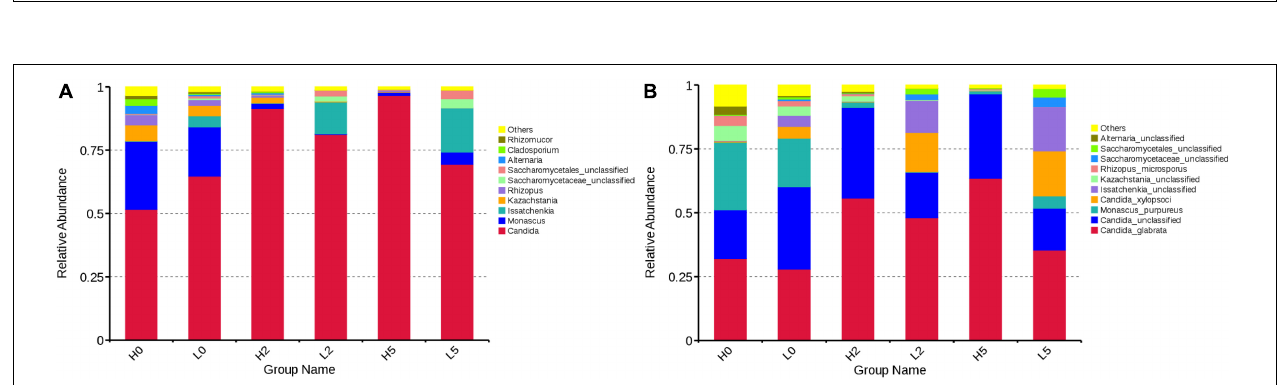
FIGURE 3 | Relative abundance of bacterial communities in whole-plant corn silage (A) , at the genera level; (B) , at the species level). H, ensiled whole corn plants with a high moisture content (680 g/kg) harvested at the one-third milk-line stage; L, ensiled whole corn plants with a low moisture content (620 g/kg) harvested at the two-thirds milk-line stage.